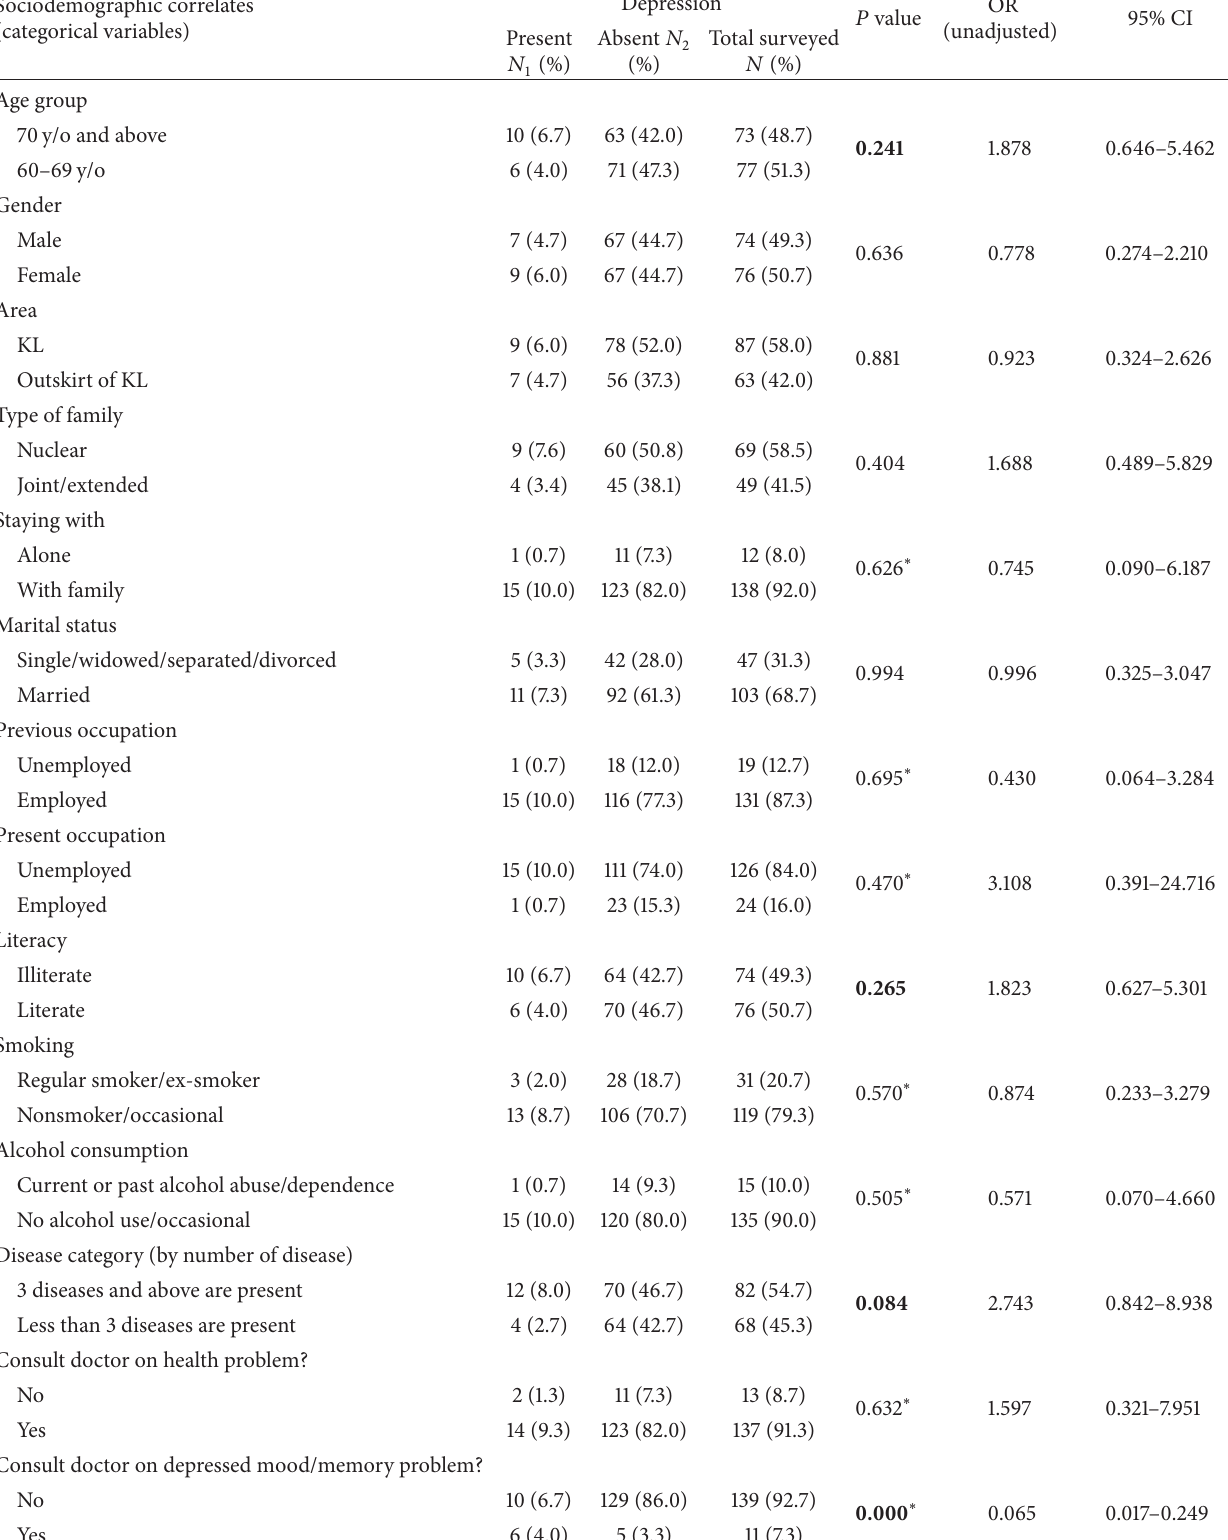
Table 2: Univariate analysis: sociodemographic correlates of